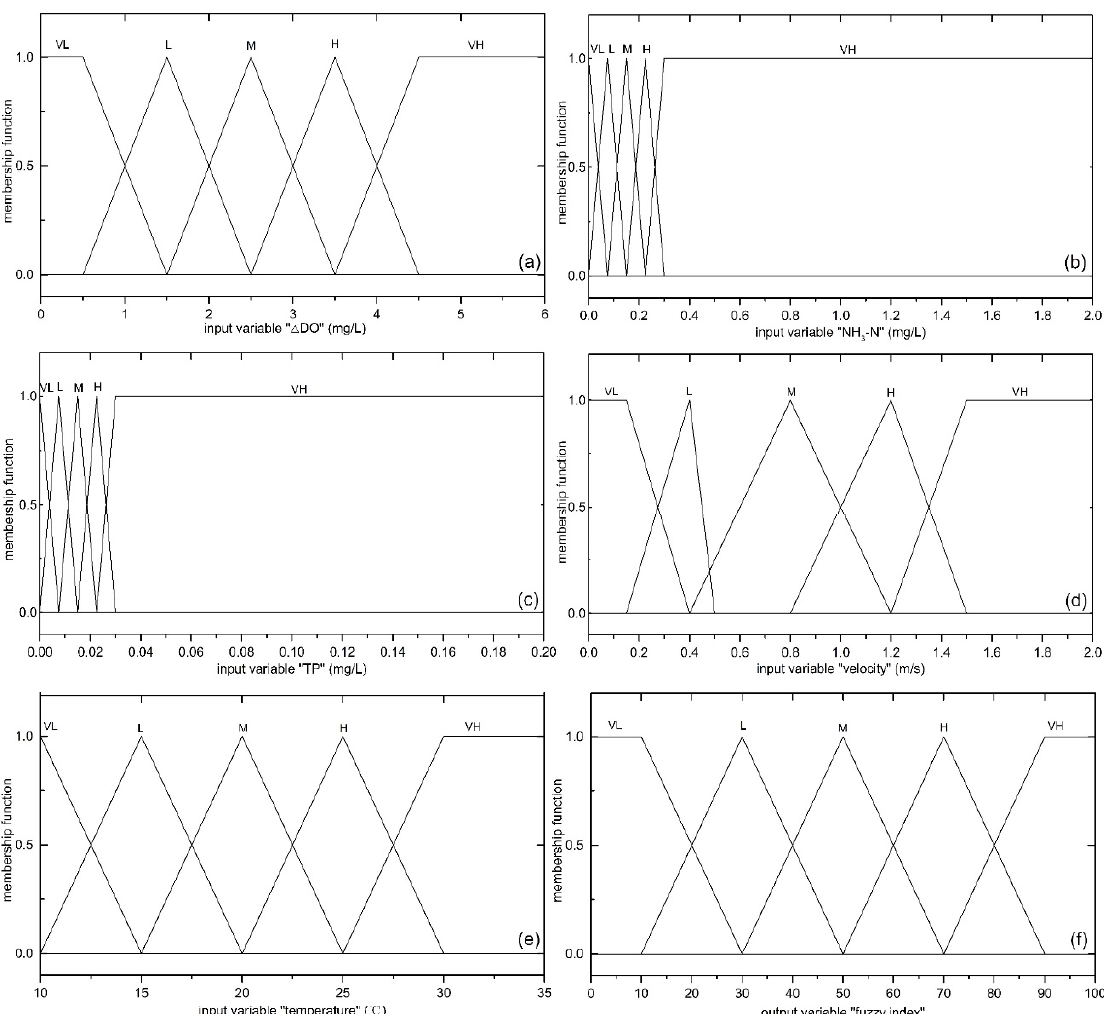
Figure 3. Schematic flow–diagram of the fuzzy model.